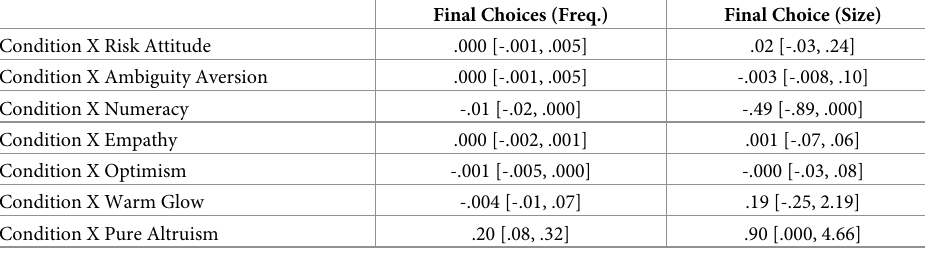
Table 8. Bayesian linear regression coefficients and 95% credible